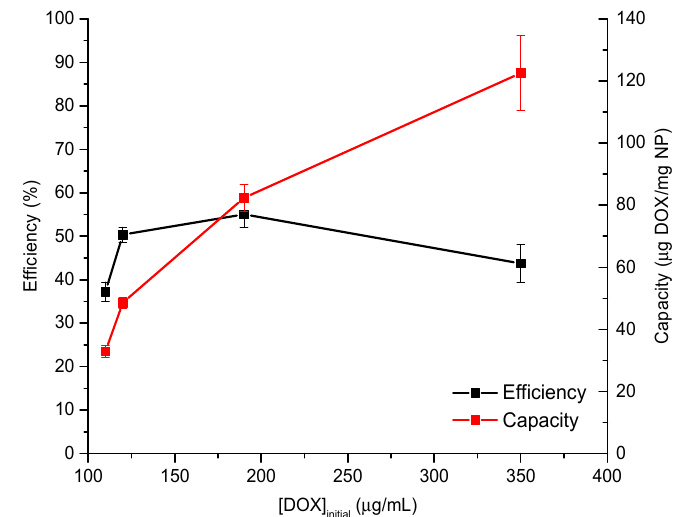
Figure 4. Uptake curve for doxorubicin, expressed in loading efficiency (%) and nanoparticle capacity ( μ g DOX/mg NP). pH = 6, [NP] = 1.25 mg/mL.